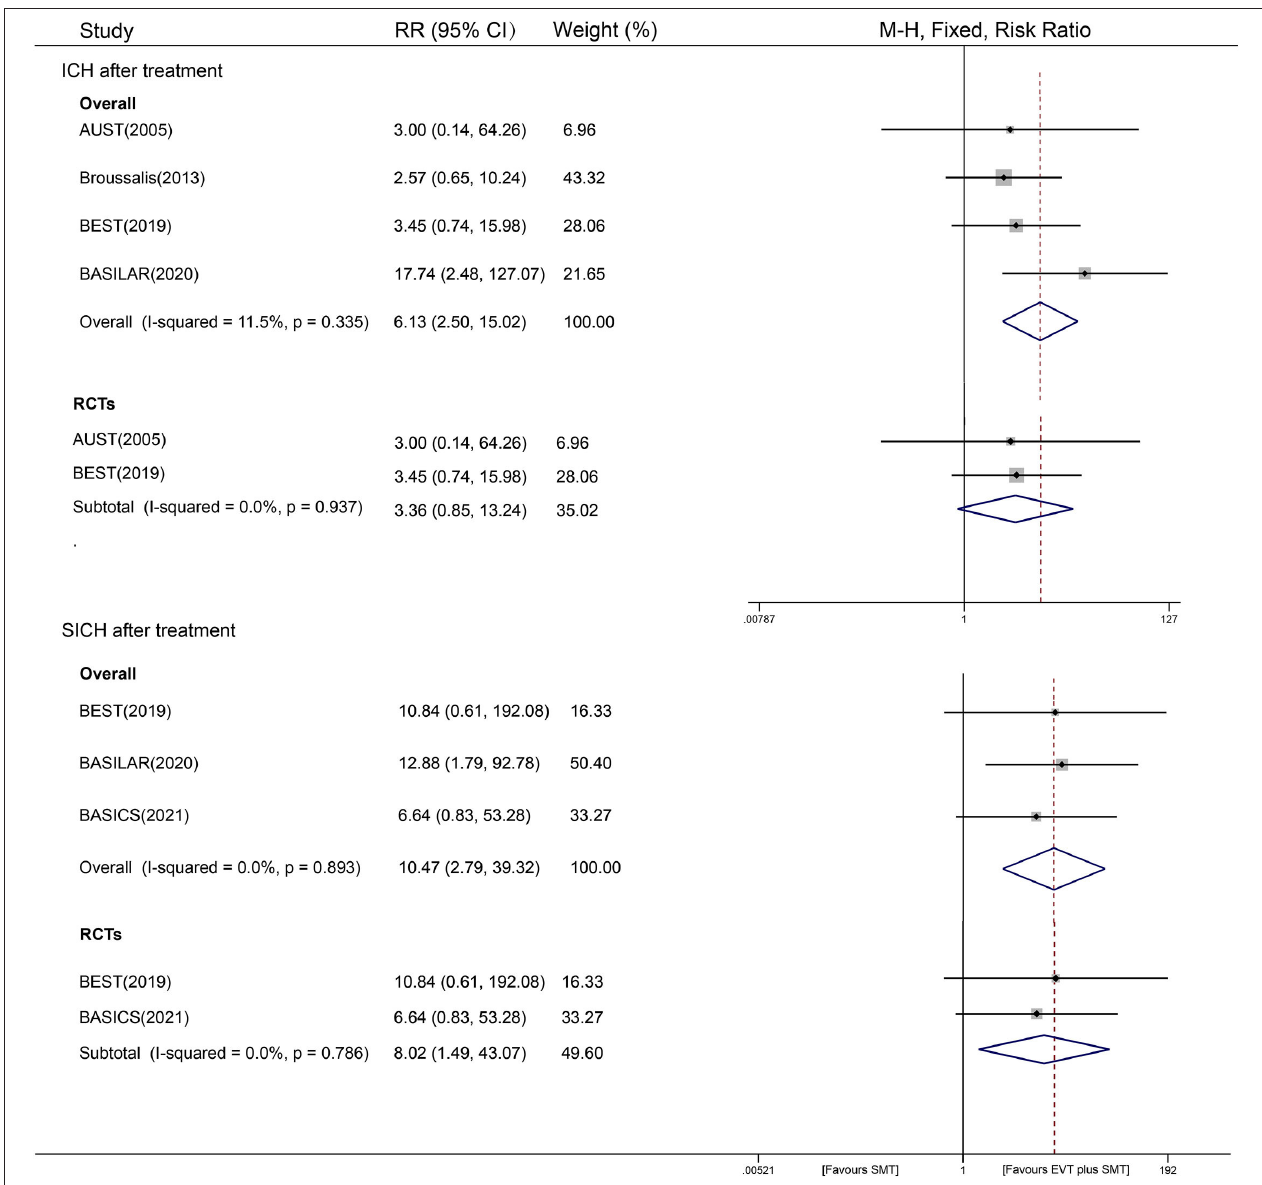
FIGURE 4 | Forest plot of ICH and sICH after treatment with fixed-effect model.